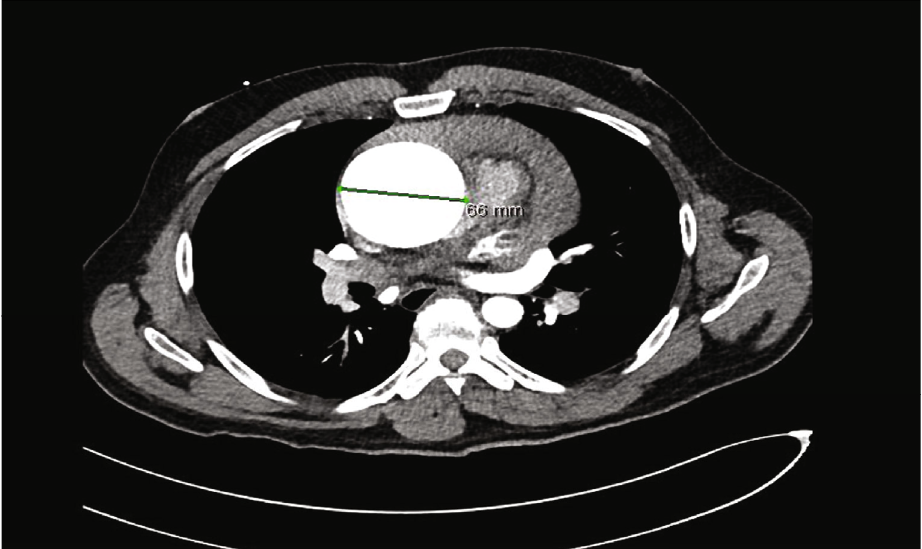
Figure 2: CT imaging with 6.6cm aneurysm of the ascending thoracic aorta without dissection. Large pericardial e ff